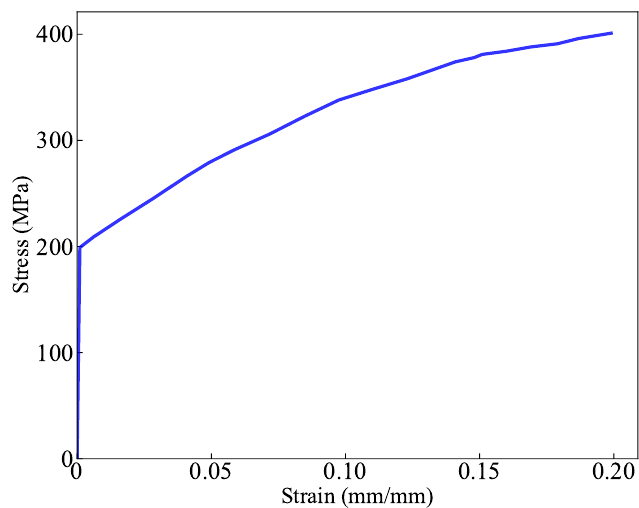
Figure 5. Material stress–strain